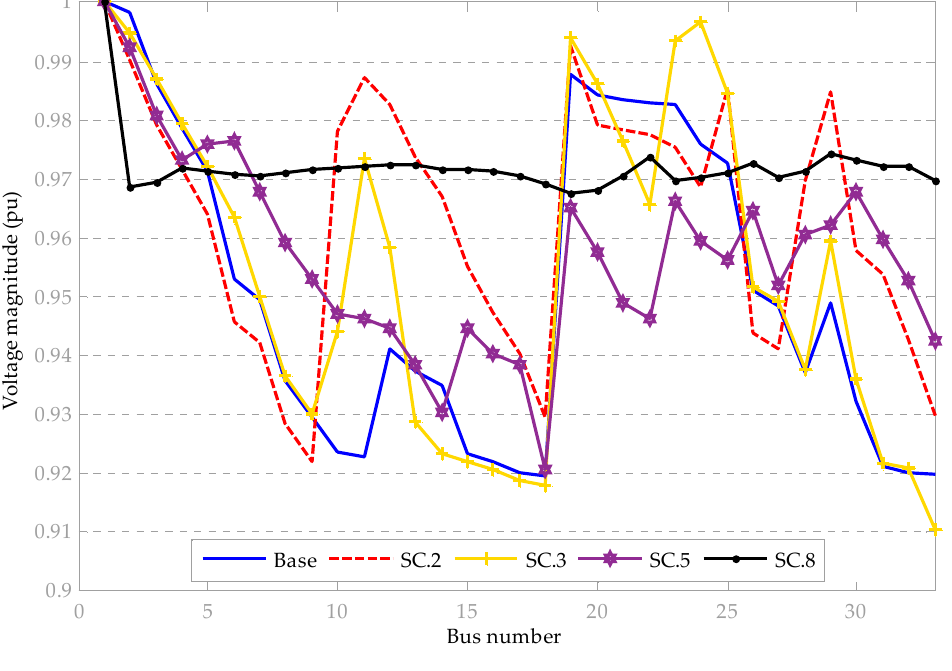
Figure 9. Voltage profile for 24-hour.